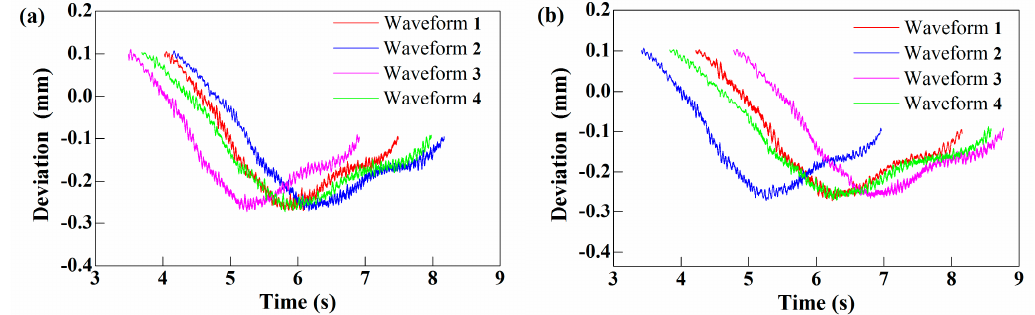
Figure 30. Combined projection waveforms: ( a ) PD is the measured surface ( b ) PC is the measured surface.